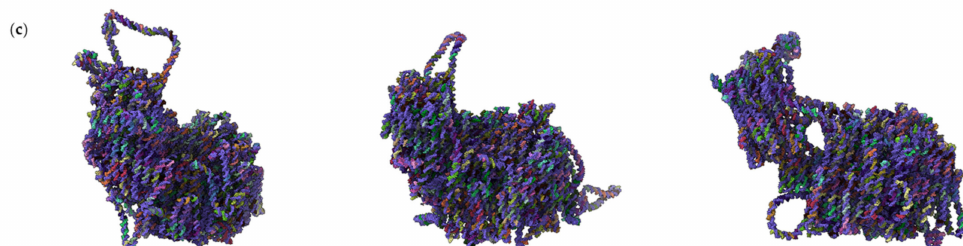
Figure 7. Isometric view of fully relaxed configuration for filling application from oxDNA simulations (from Figure 6): ( a ) OxDNA 3D structure with the tetrahedron as the outer bounds of the design space. Each configuration, from left to right, has a total length of 7595 bp, 7784 bp, and 7728 bp; ( b ) OxDNA 3D structure with the snub cube mesh as the outer bounds of the design space. Each structure, from left to right, has a total length of 9275 bp, 8484 bp, and 8582 bp; ( c ) OxDNA 3D structure with the Stanford bunny mesh as the outer bounds of the design space. Each configuration, from left to right, has a total length of 14,595 bp, 13,531 bp, and 14,105 bp.